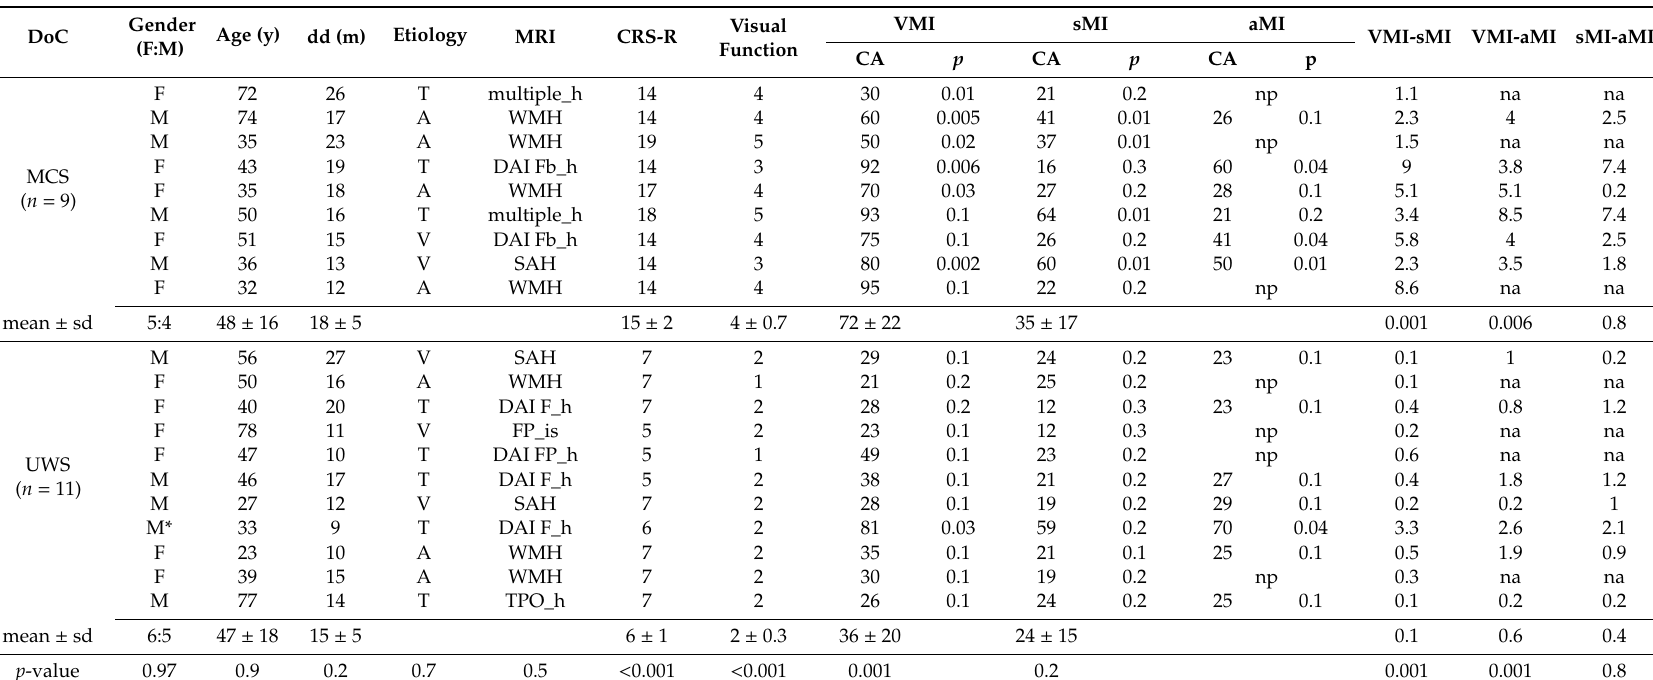
Table 1. Shows the clinical demographic characteristics and the features of electroencephalography (EEG) during the visuomotor imagery (VMI), simple (sMI), and advanced motor imagery tasks (aMI) (EEG classification accuracy (CA), %, and p -value for EEG command following; for the post hoc analysis, CA were compared at individual level using the reliable change index, and at a group level by t -tests). The possibly misdiagnosed patient with UWS (no.8) is highlighted with *. Legend: DAI di ff use axonal injury, WMH white matter hyperintensity, F frontal, Fb frontobasal, FP frontoparietal, _h hemorrhagic lesion, _is ischemia, SAH subarachnoid hemorrhage, TPO temporo-parieto-occipital, dd disease duration, T traumatic, V vascular, A anoxic, na not applicable, np not